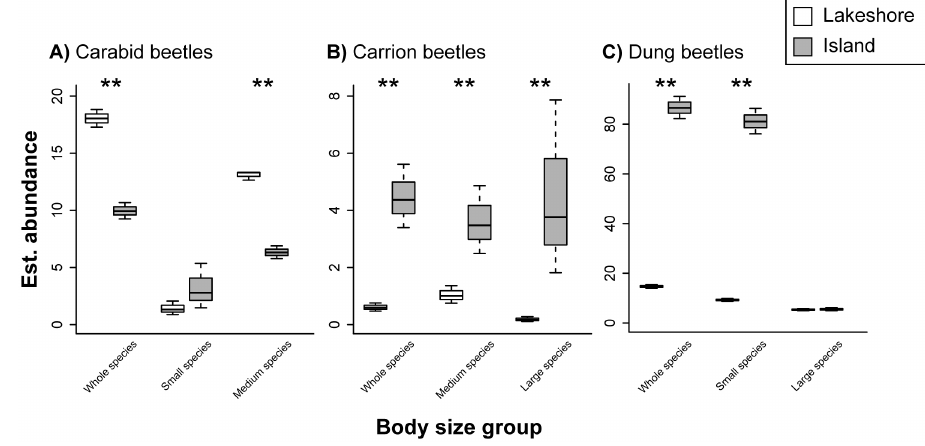
Figure 2. Abundance of each insect taxonomic and functional group per plot at the island and lakeshore sites estimated by using GLMs. A Carabid B Carrion C Dung beetles. Carabid and carrion beetles were classified into small, medium and large species and dung beetles were classified into small and large species (see the main text). Asterisks indicate a significant difference ( p < 0.05).